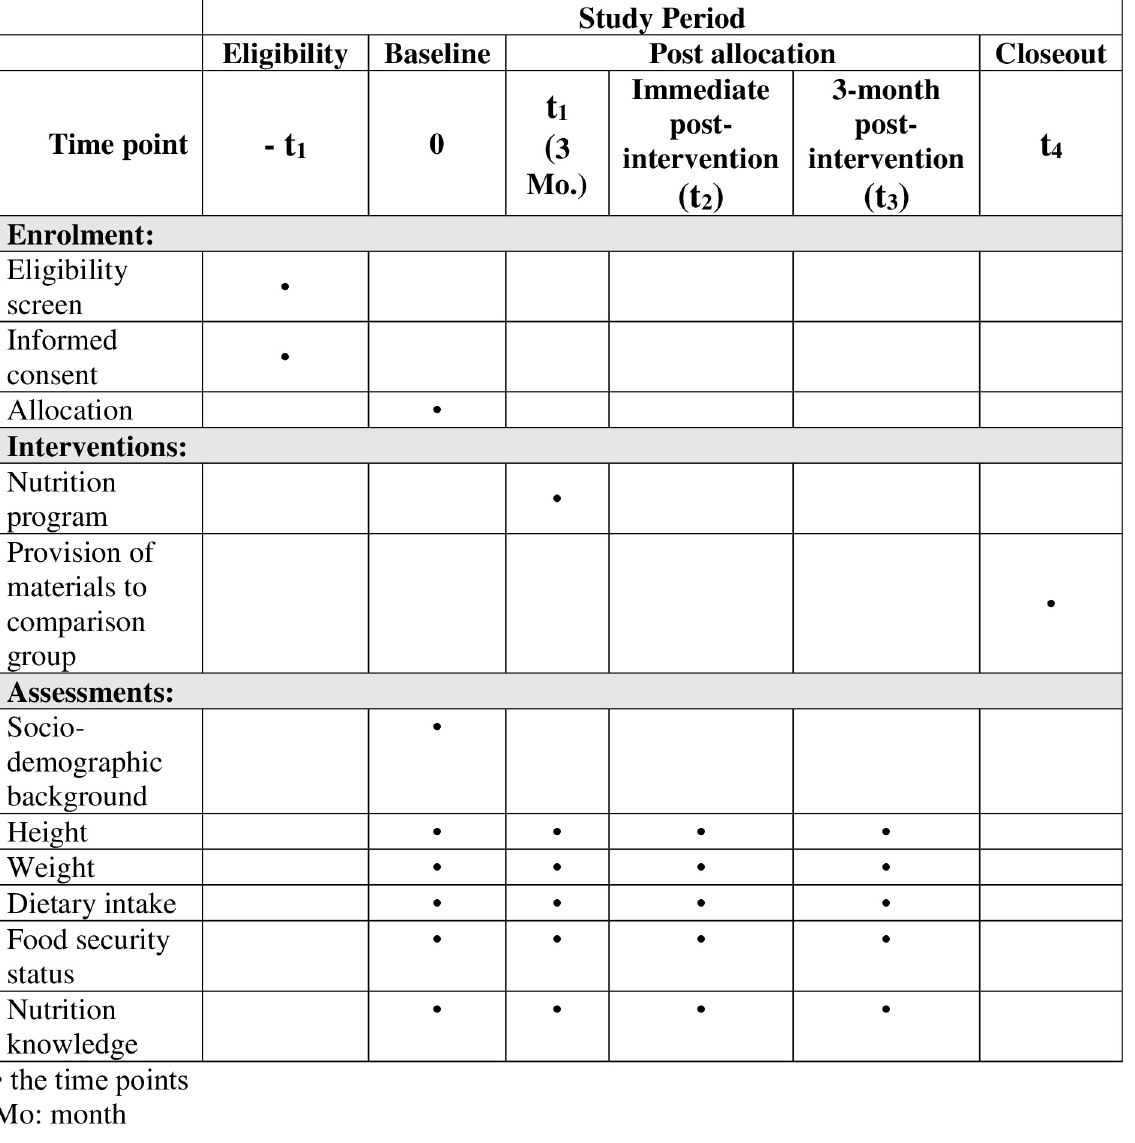
Fig 1. The study timeline. • the time points; Mo: